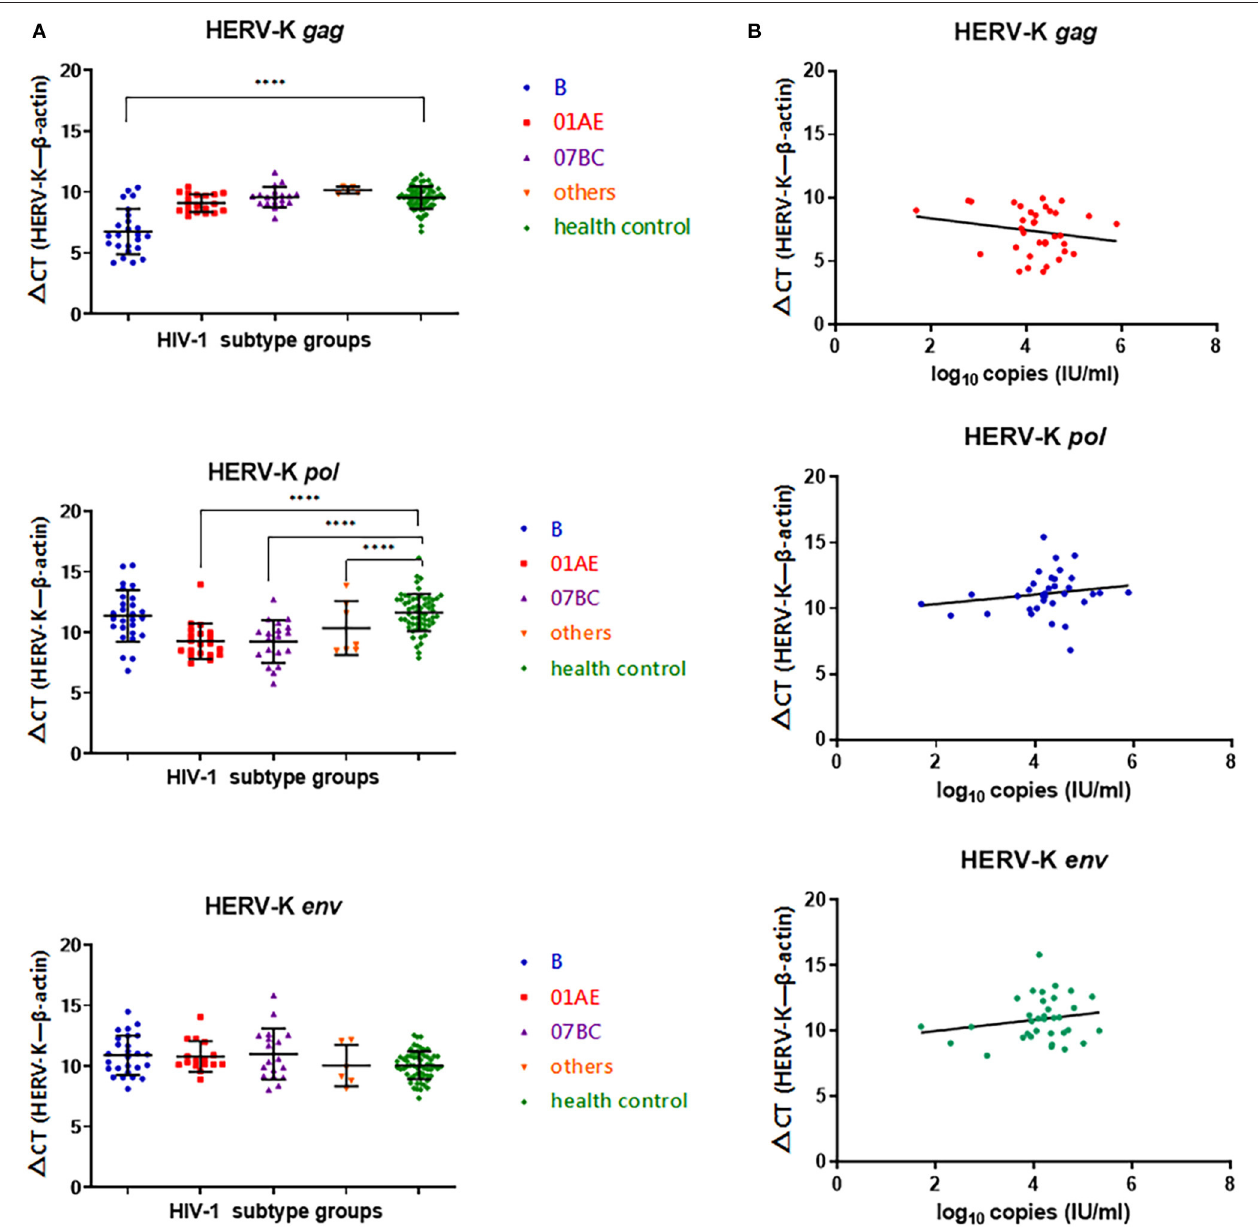
FIGURE 1 | (A) Blue represents HIV-1B subtype-infected persons, red represents HIV-1 CRF01_AE subtype-infected persons, purple represents HIV-1 CRF07_BC-infected persons, yellow represents other CRFs and URFS-infected persons, and green represents the healthy population control group. The Y-axis is 1 CT = CT < 0.05, ** P < 0.01, *** P < 0.001, **** P < 0.0001. (B) Red represents transcriptional levels in the HERV-K gag region, blue represents HERV − K − CT β − actin . * P transcriptional levels in the HERV-K pol region, and green represents transcriptional levels in the HERV-K env region. The Y-axis is 1 CT = CT HERV − K − CT β − actin . The X-axis represents log 10 of the viral load in each infected person. Connecting curves are